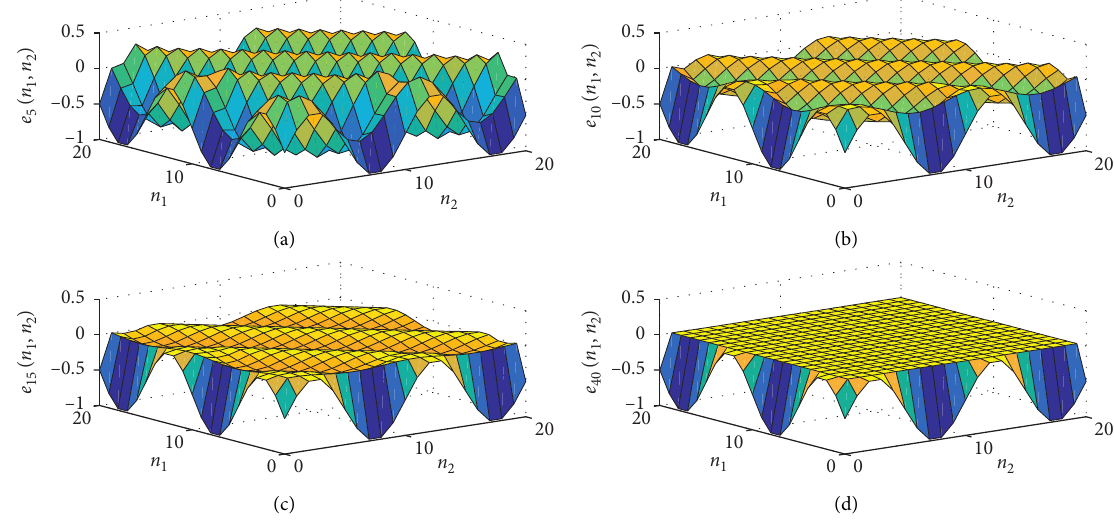
Figure 7: Tracking error surface e